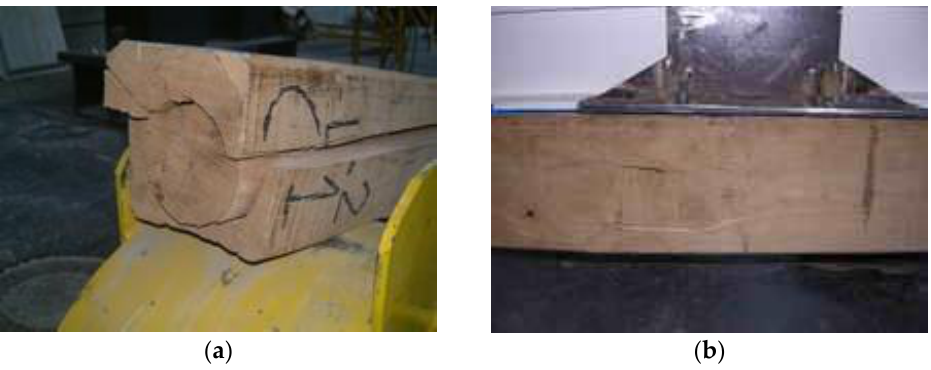
Figure 6. Failure modes: ( a ) unreinforced timber beam; ( b ) reinforced beam.